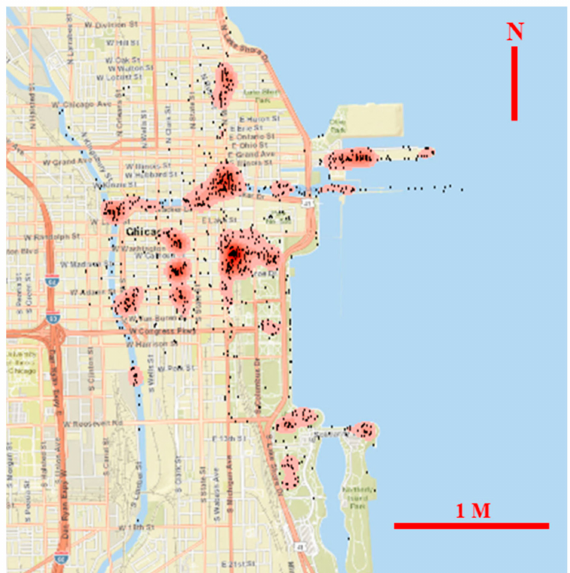
Figure 4. Map shows the spatial distribution of photographs taken by study participants along a kernel density overlay. Dots placed over the Chicago River and Lake Michigan represent locations of photographs taken by participants while they were on a boat tour. Color variation indicates the intensity of the taken photographs: the heavier color indicates a greater number of registered photographs, and the lighter color indicates a lesser